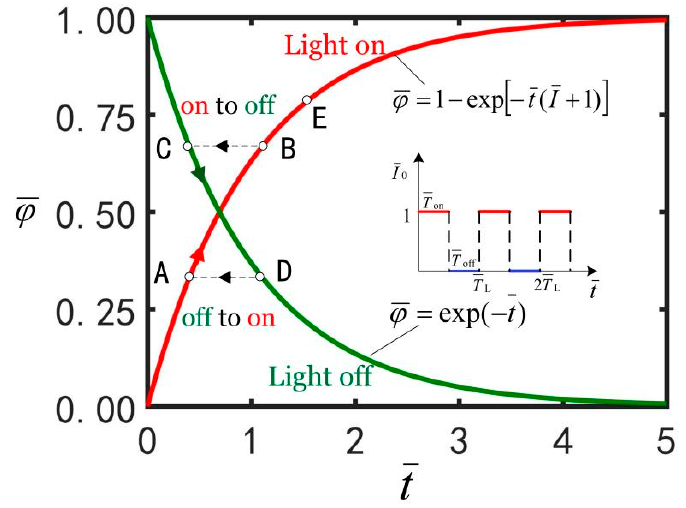
( ) (cid:0) (cid:1) t t ϕ in the balloon with time in the balloon with time t